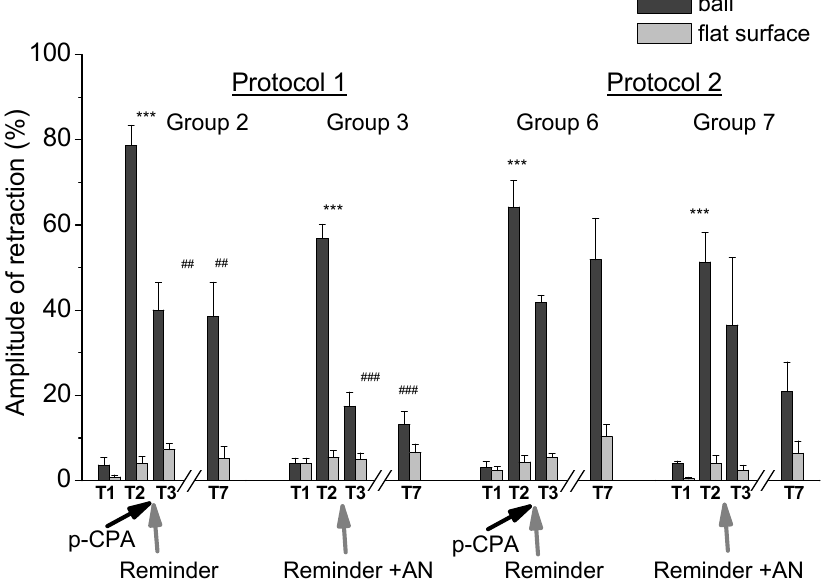
Figure 5. The level of the defensive response (the amplitude of the response of ommatophores withdrawal) of snails in two contexts, on the ball and flat surface for the experimental series 1 (protocol 1; Groups 2 and 3) and experimental series 2 (protocol 2; Groups 6 and 7). T1—initial testing before the beginning of training, T2—testing 2 days after elaboration of the conditioned reflex (learning), T3–T7—testing of animals after the injections of PCPA, AN and a reminder on the 4th–8th day after a reminder. Arrows indicate: PCPA—time of injection of PCPA (3 days before a reminder and injection of AN), Reminder—time of reminder, AN—time of injection of AN. Asterisks and hash signs indicate a significant di ff erence of the amplitude of the response of ommatophores withdrawal in responses to T3–T7 vs. the amplitude of the response of ommatophores withdrawal in responses to T2 by a paired t -test ( ## ) equal to p < 0.01; ( ### ) equal to p < 0.001 and T2 vs. the amplitude of the response of ommatophores withdrawal in responses to T1 by a paired t -test (***) equal to p < 0.001. The vertical axis shows the value of the defensive reaction in response to a conditioned stimulus (the amplitude of the reaction of ommatophores withdrawal), in % to maximum. Horizontal axis shows the course (protocol) of the experiment: T1, T2, T3–T7, PCPA, AN and Reminder. Thus, blockade of tryptophan hydroxylase by p-chlorophenylalanine after reminding the